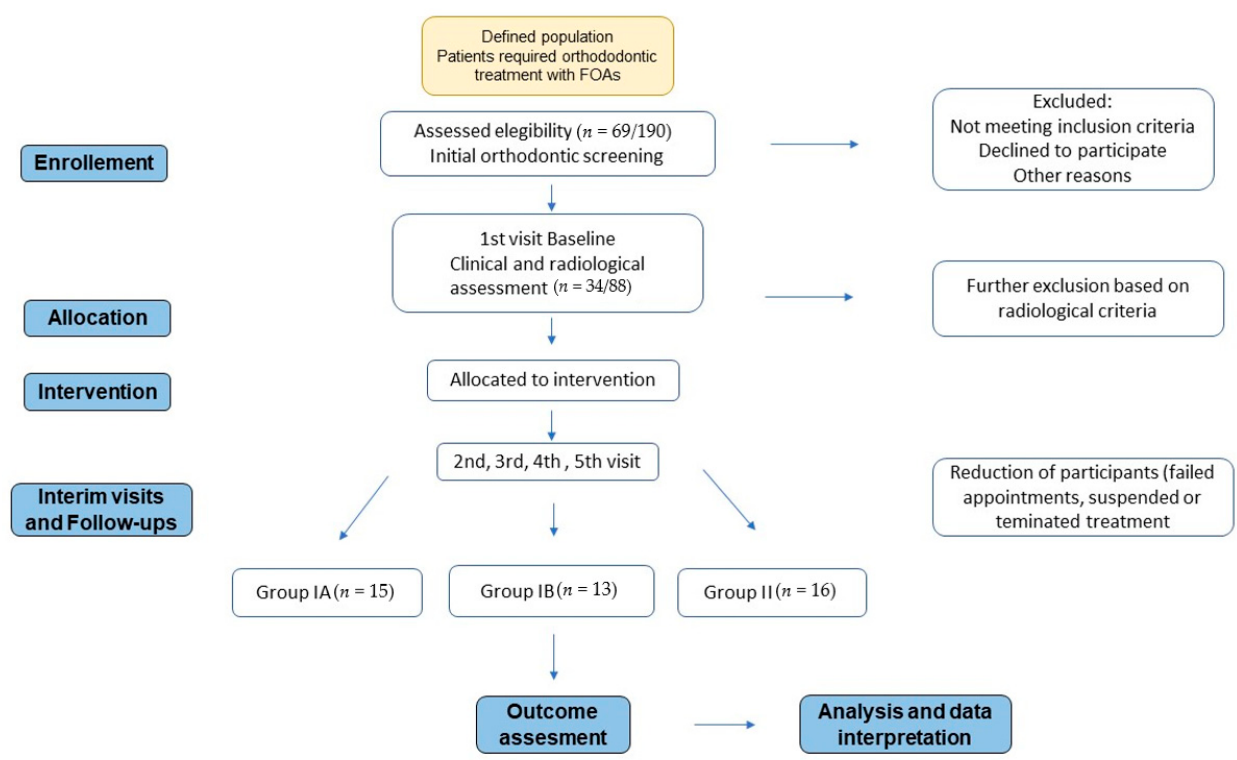
Figure 1. Structured protocol of prospective cohort study. Flow diagram.